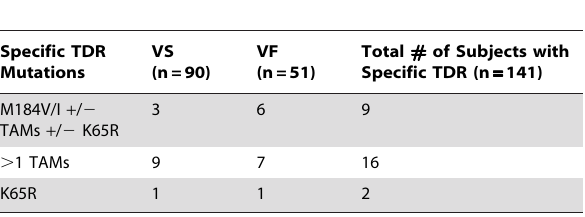
Table 3. Virologic outcome at Week 48 and specific TDR at Baseline known to affect NRTI Backbone.